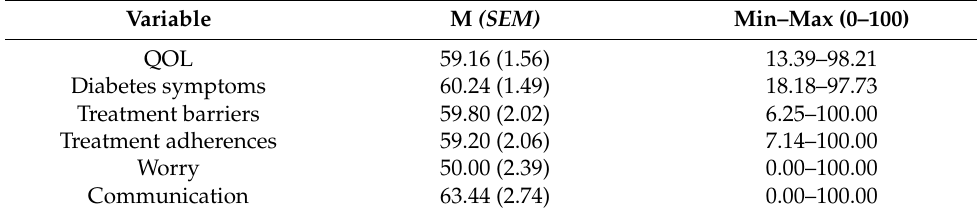
Table 2. Descriptive Statistics of QOL ( N = 111).